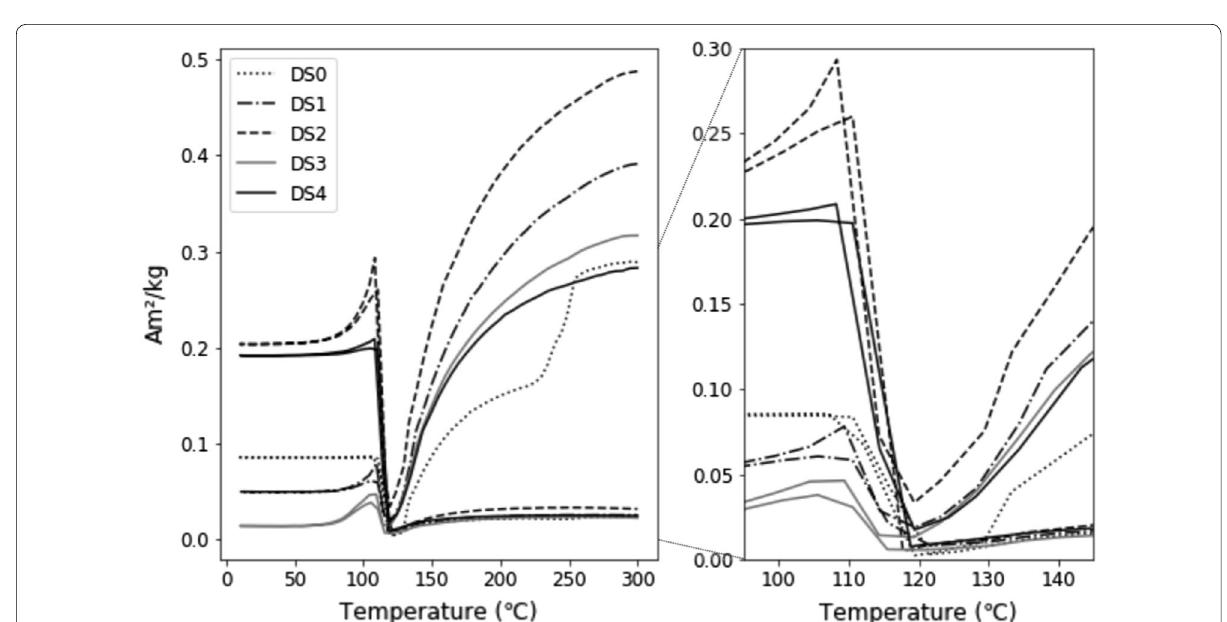
Fig. 3 Left shows RTSIRM measurements for all five samples. Samples DS2 and DS4, which were deformed at lower temperatures and have